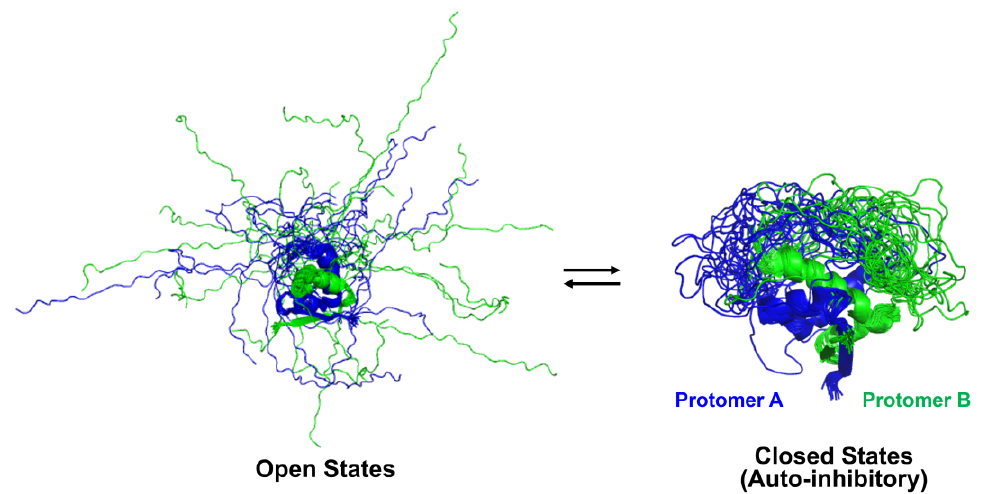
Figure 3. Open and closed states of the antitoxin CcdA in solution. Both open and closed states of the antitoxin CcdA in the absence of the cognate toxin CcdB are described as an overlay of the 20 best NMR structures in solution.